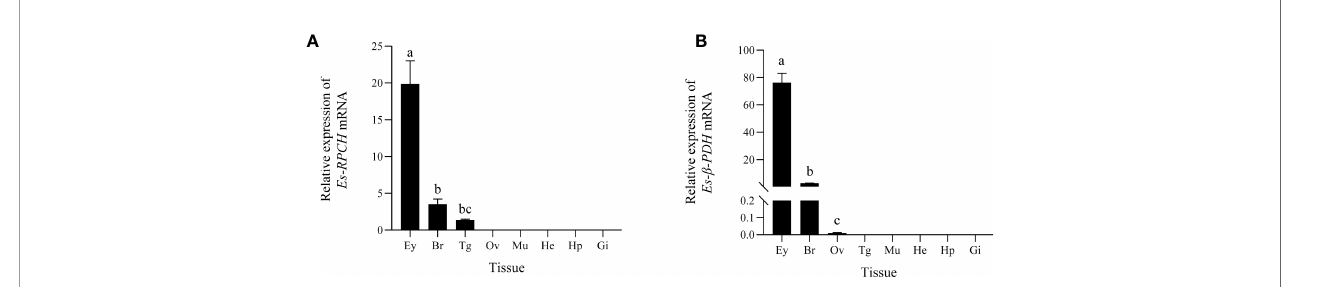
FIGURE 2 | QRT-PCR detection of the tissue distribution of Es-RPCH (A) and Es- b -PDH (B) mRNAs in E. sinensis . Ey, eyestalks; Br, brain; Tg, thoracic ganglia; Ov, ovary; Mu, muscle; He, heart; Hp, hepatopancreas; Gi, gill. Different letters indicate signi fi cant differences